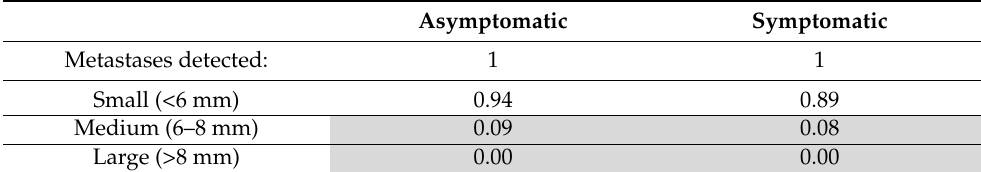
Proportions of oligo+ per risk sub-group. Grey fields represent the low-risk group. This scenario has fewer sub-groups than the Base